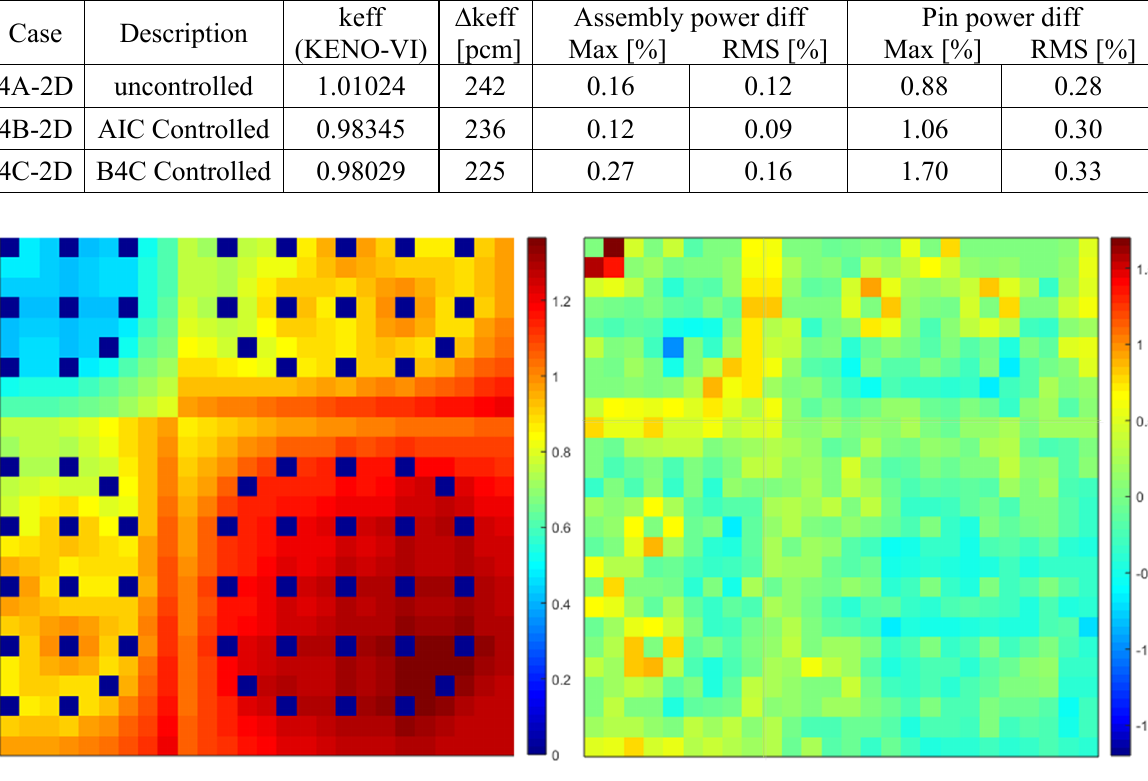
Figure 7. Pin power (KENO-VI, left) and relative error of pin power (KYLIN-V2.0 vs KENO-VI, right) for 4C-2D multi-assembly